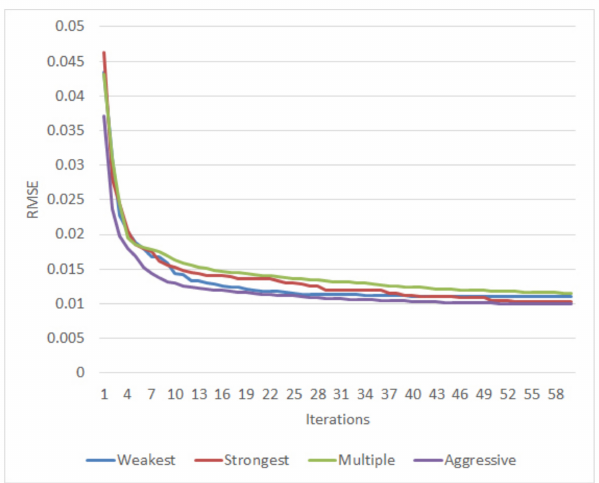
Figure 8. Comparison of convergence using various competition strategies: weakest—the highest-cost imperialist loses a colony to one of the other imperialists; strongest—the lowest-cost imperial gains a colony from one of the others; multiple—the conquering and conquered imperialists are both chosen based on their costs; aggressive—the highest-cost imperialist loses several colonies to the others.